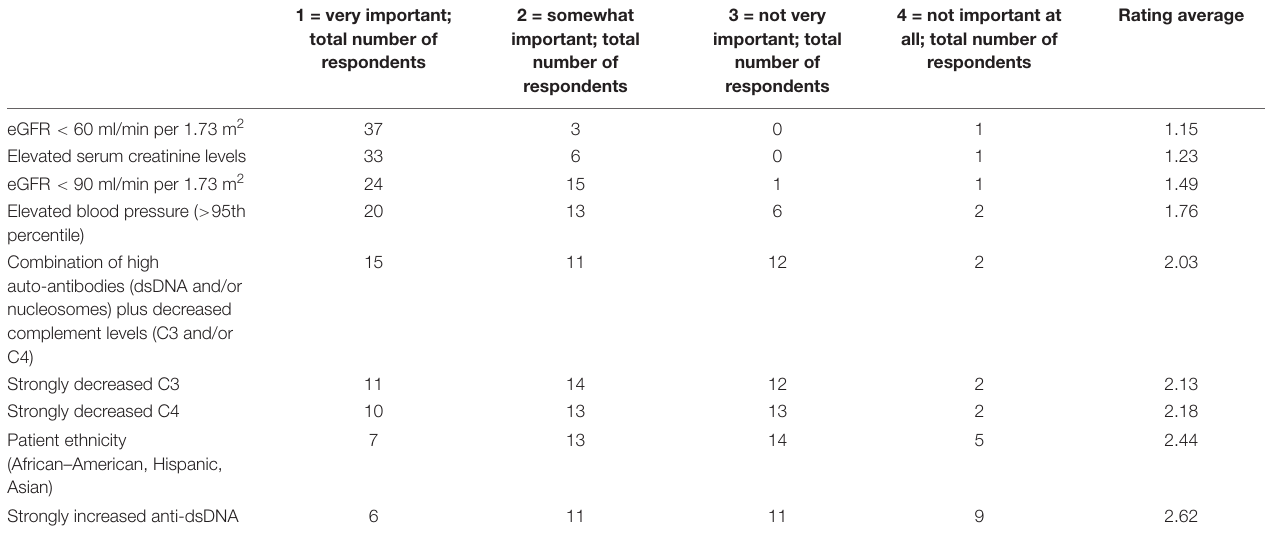
TABLE 3 | Other relevant parameters for the indication of a kidney biopsy (answers by Likert scale: 1 = very important, 2 = somewhat important, 3 = not very important, 4 = not important at all; with rating average of respondents). 1 = very important; total number